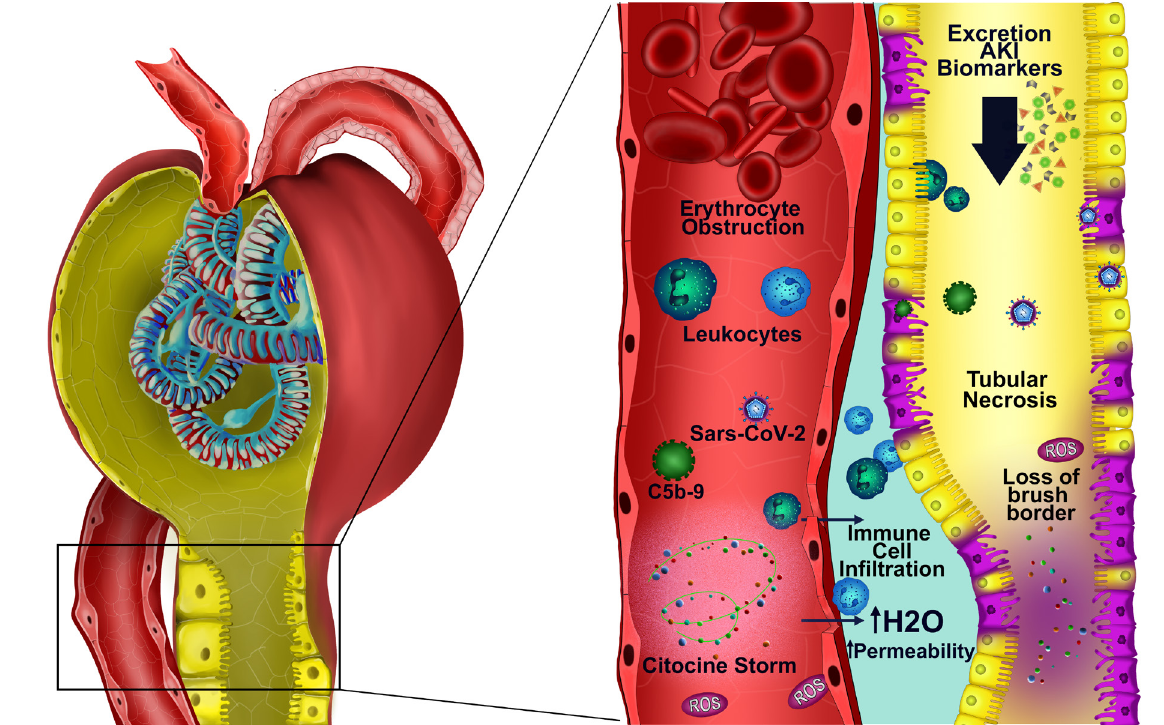
Figure 3. Indirect effects of SARS-CoV-2 associated with acute kidney injury. The hypercytokinemia contributes to the dysregulation of the coagulation pathways, complement system, increased endothelial permeability, and generation of reactive oxygen species (ROS). An erythrocyte aggregation can be noted, obstructing the capillary lumen, contributing to renal hypoperfusion. Furthermore, sites with low oxygen concentrations can contribute to the generation of ROS, further enhancing the reduction in arteriolar blood flow. Increased vascular permeability is associated with the inflammatory response, facilitating the passage of immune cells and water to the interstitial space, with the consequent formation of edema. SARS-CoV-2, ROS, leukocytes, and the deposition of the complement system (C5b-9) can potentiate damage to kidney cells. The reduction in renal perfusion, together with direct damage to the cells of the proximal tubule, allows for acute tubular necrosis (ATN) and loss of the brush border, progressing to